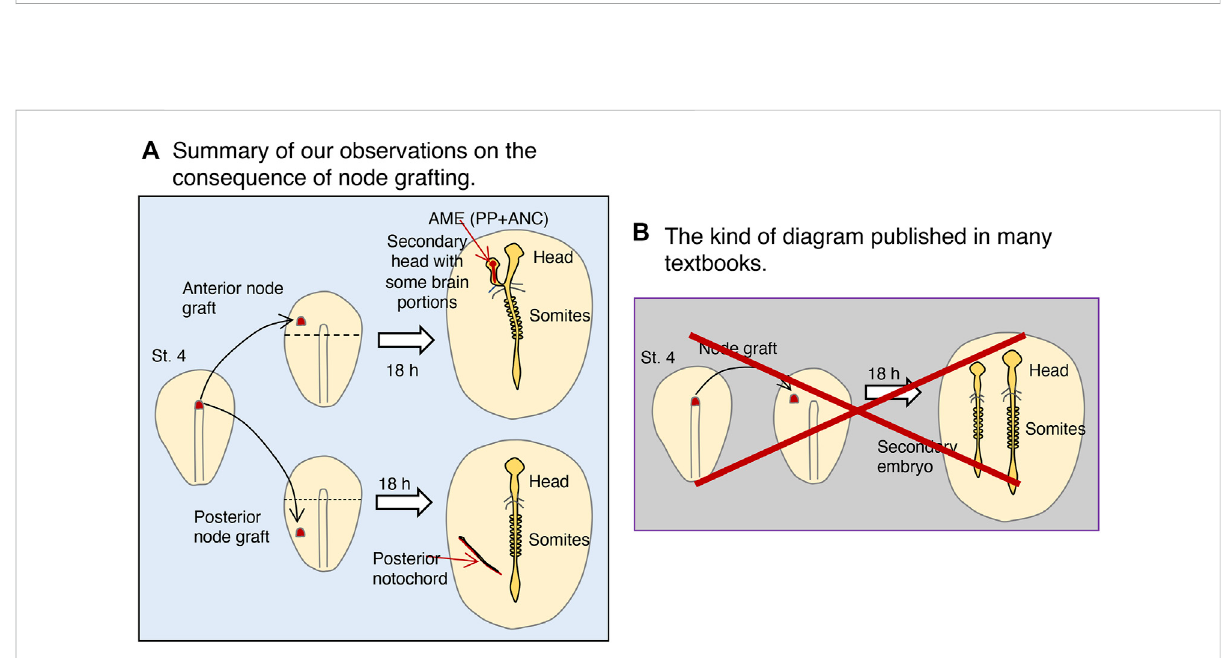
FIGURE 8 The consequence of st. 4 node grafting into st. 4 host embryos: the true and the erroneous. (A) Summary of our observations on the result of nodegrafting.Thegraftednodedevelopeddifferentlydependingonwhetherthegraftwasontheanteriororposteriorhalfoftheembryo,separated by the horizontal broken line. Only after node grafting at an anterior position did the node-derived AME extend, to which the nearby epiblast converged and developed into the brain portions. (B) The kind of diagram published in many textbooks, which are erroneous. This method of systematic grafting has not been done previously (see Box 2). Node grafting does not elicit secondary posterior embryonic structures of host origin (e.g., somites) (see Figure 4).